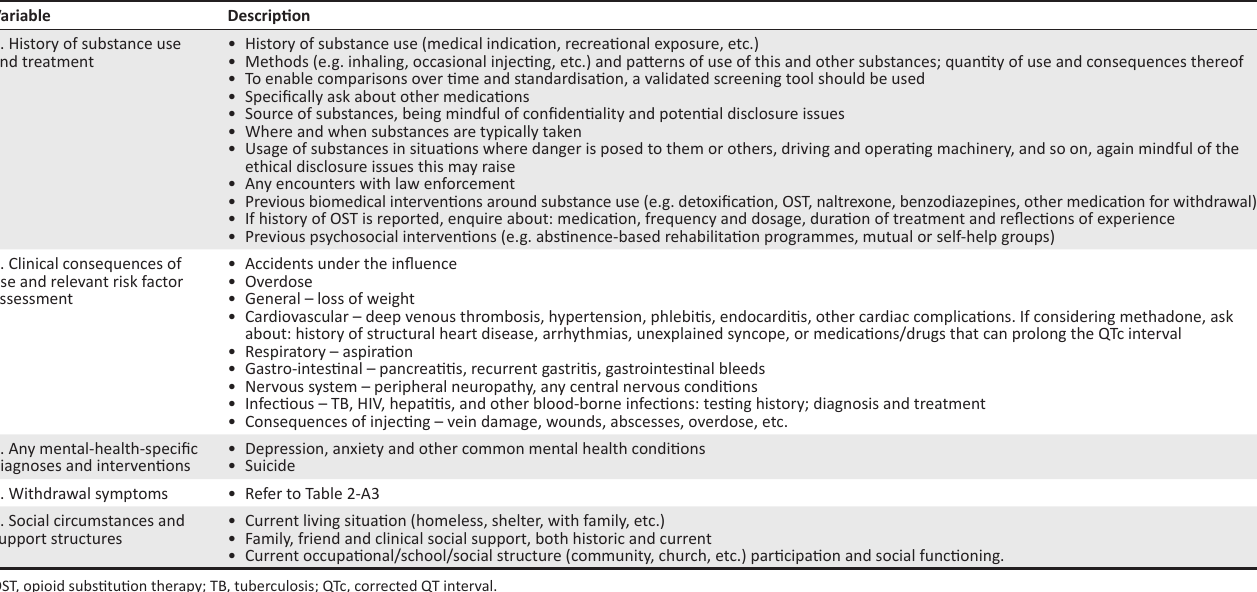
TABLE 1-A3: Taking clinical history for opioid substitution therapy. 74,83 † Variable